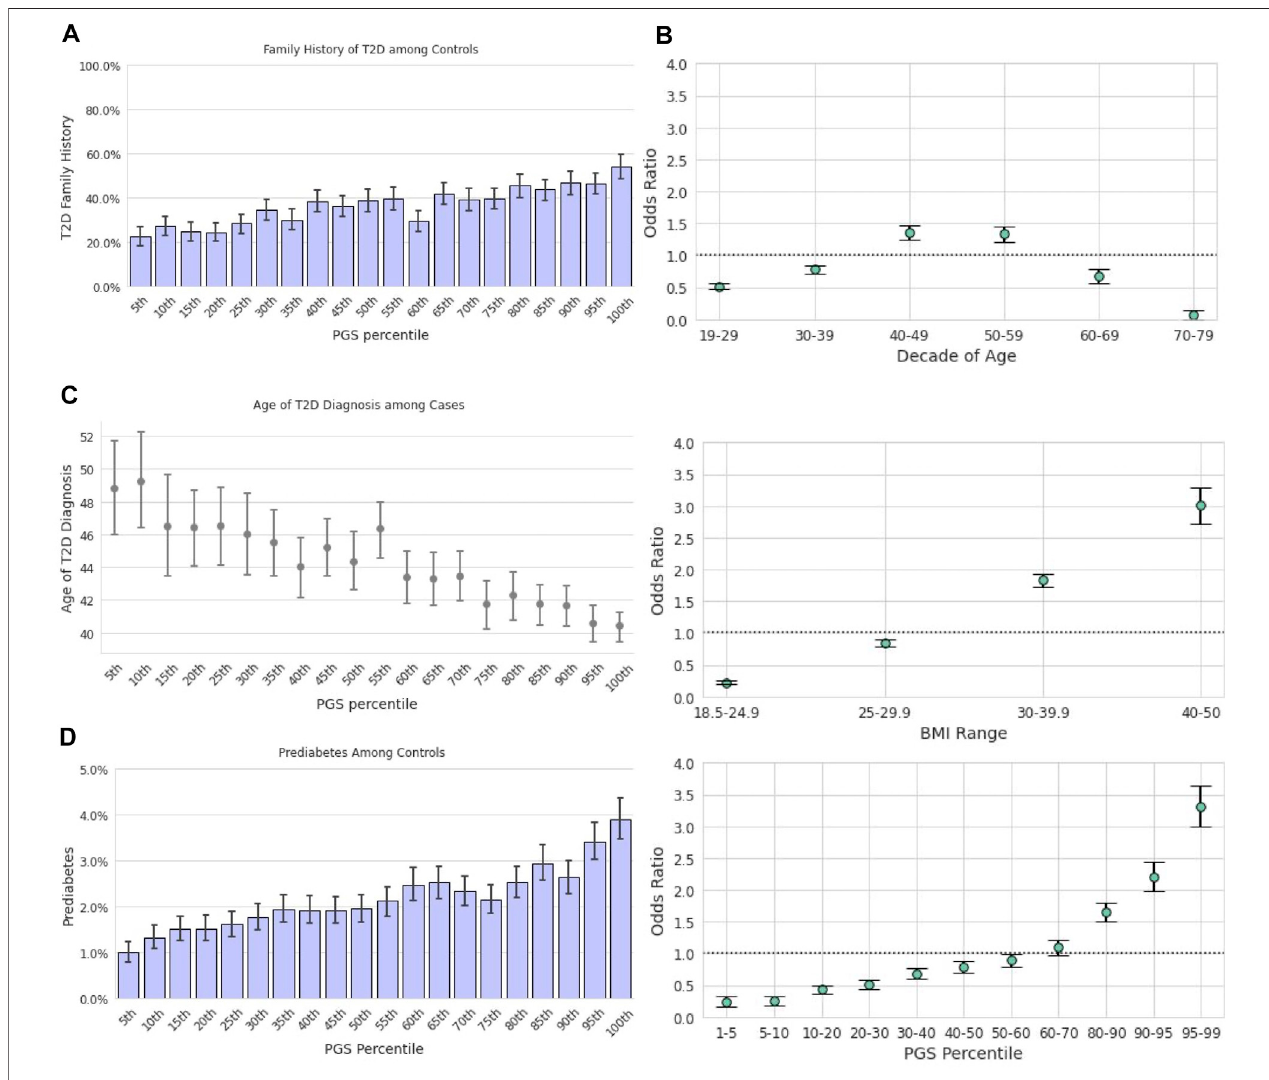
FIGURE 5 | Repeated analysis in the Hispanic/Latino sample. (A) : The prevalence of family history of T2D among T2D-negative participants. Data among T2D- positiveparticipantsarenotprovided duetoprivacypractices. (B) :Oddsratios (y-axis)ofhaving T2DrelativetotheHispanic/Latino studypopulation werecalculatedfor each decade of age, BMI category, and Latino-speci fi c PGS percentile. Error bars represent analytically computed 95% con fi dence intervals. (C) : Mean age at T2D diagnosis among cases (y-axis) is plotted against Hispanic/Latino-speci fi c PGS ventiles (x-axis) among participants who self-reported their age at T2D diagnosis. Errorbarsrepresentempiricallyderived95%con fi denceintervals. (D) :TheprevalenceofprediabetesamongT2D-negativeparticipantswassigni fi cantlyassociatedwith the PGS, as shown with increasing ventiles of the PGS distribution. Data among T2D-positive participants are not provided due to privacy practices.